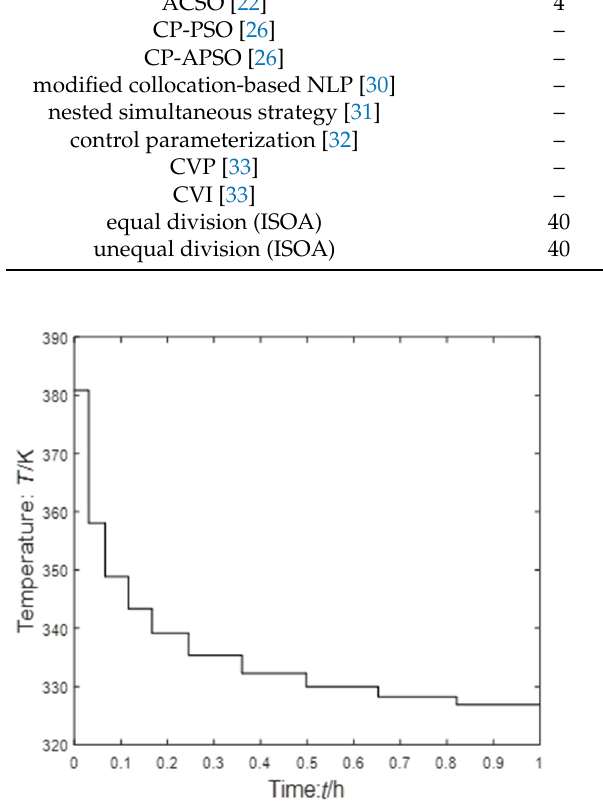
Figure 2. Optimal temperature control trajectory ( N = 10).